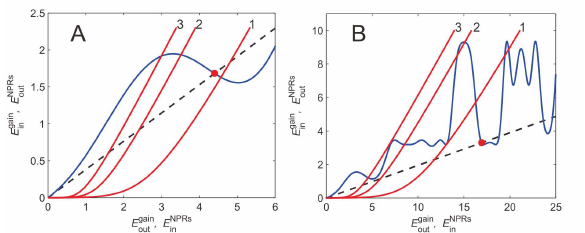
Figure 9: (A) Geometrical description of the multipulsing process in mode-locked lasers with saturable gain and nonlinear loss. (B) Enhancement of single-pulse energy by engineering the nonlinear loss curve using two NPEs. (Adapted from